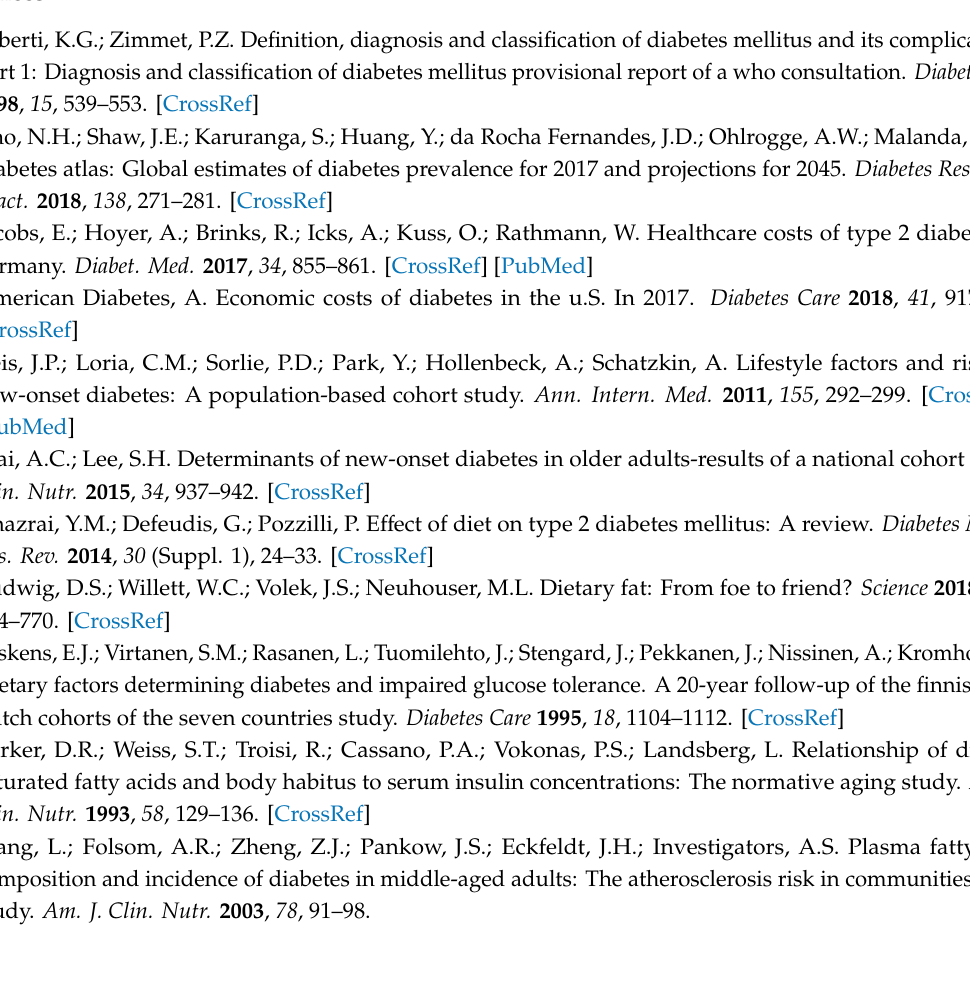
Table S1: Quality score of included studies for systemic review and meta-analysis; Table S2: Characteristics of included studies for meta-analysis (Per 1 SD